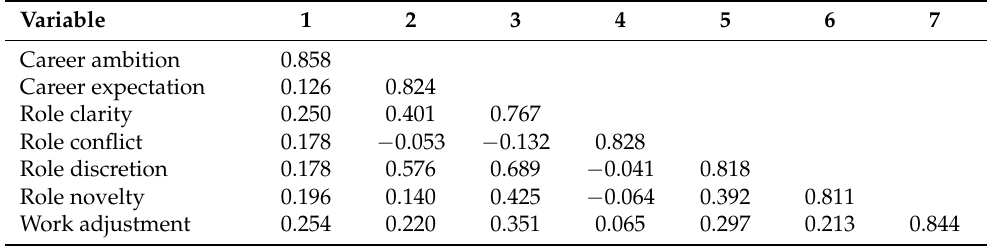
Table 4. Fornell and Larcker